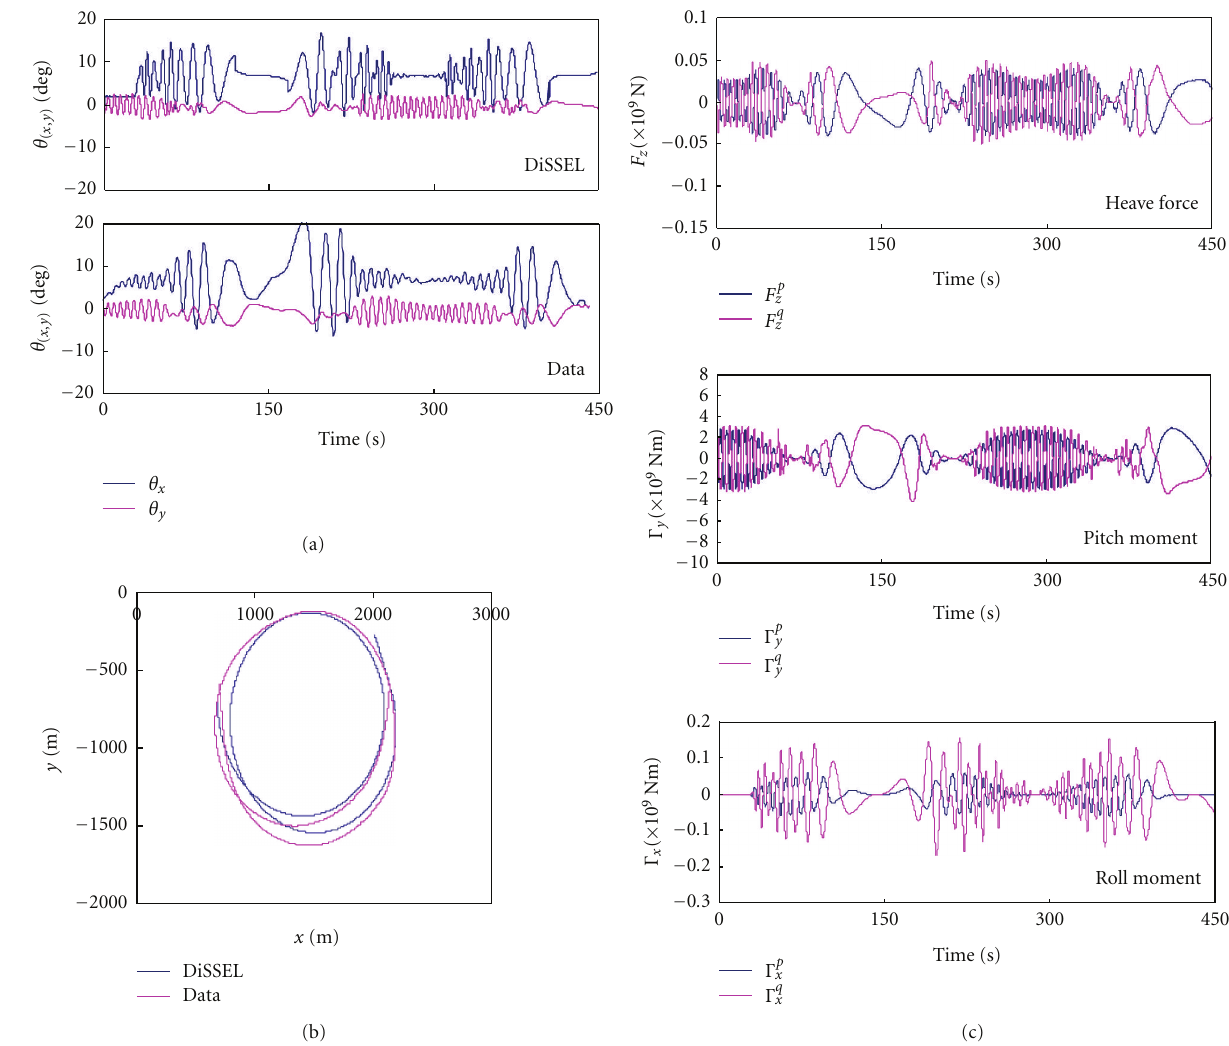
Figure 5: (a) Same as Figure 4(a), but for the case F r = 0 . 368, δ = 14 . 4 ◦ , wh = 2 . 992 m, λ = 1 . 0 (Case 4). (b) Same as Figure 4(b), but for Case 4. (c) Same as Figure 4(c), but for Case